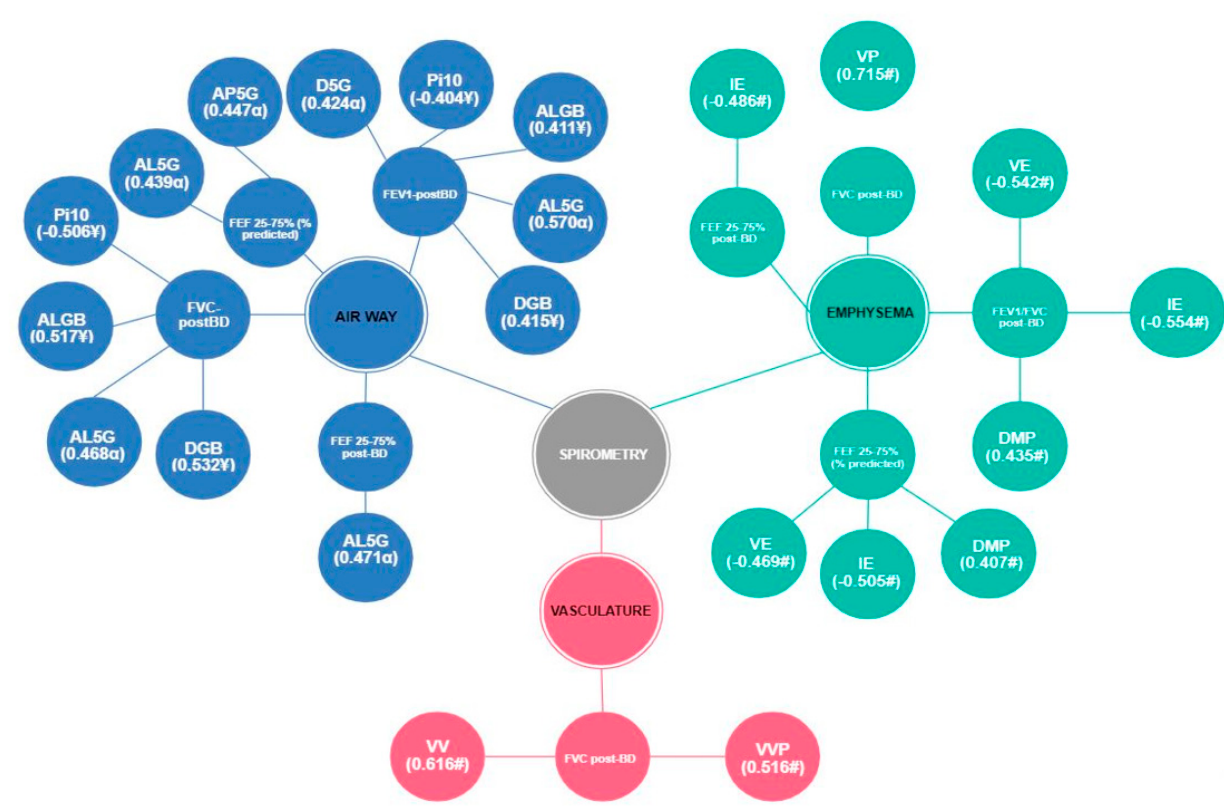
Figure 1. Linear correlation analysis between spirometry and CT data in the COPD group. BD— bronchodilator; FVC—forced vital capacity; FEV 1 —forced expiratory volume in one second;